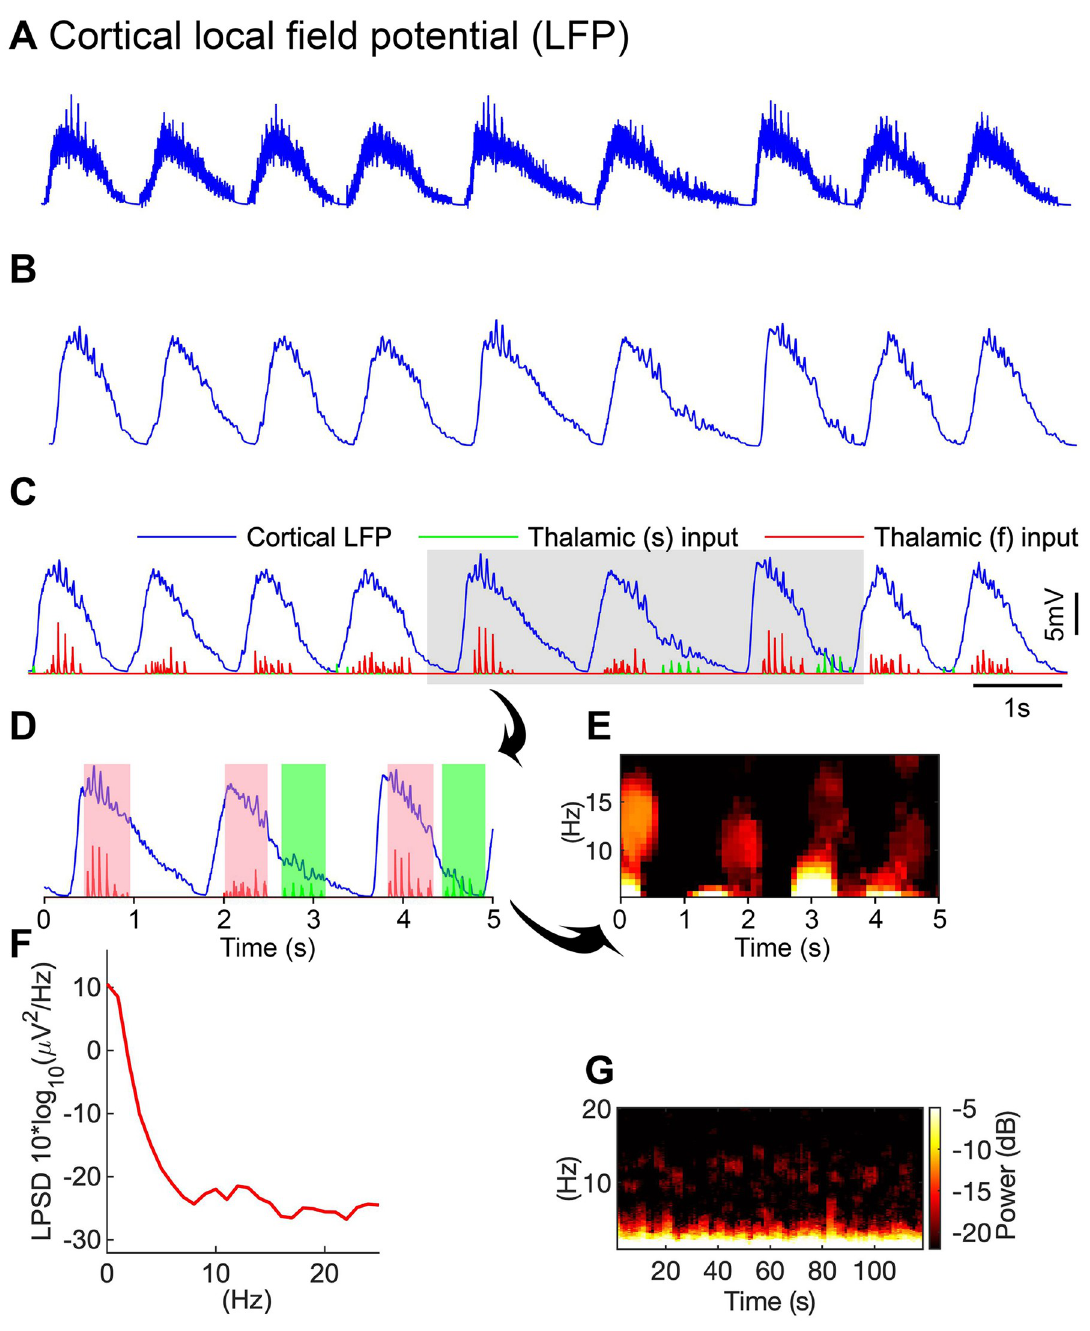
Fig 3. Resultant cortical local field potential (LFP). A , Cortical LFP calculated as the sum of presynaptic currents (AMPARs, NMDARs, GABA A Rs) of PY cells. B , Smoothed LFP revealing up and down SO states more clearly. C , Spontaneously occurring Cortical LFP indicating times of both thalamic synaptic inputs. The occurrence of slow and fast spindles varies during long time simulations. The ‘fast thalamic’ input (red) responsible for fast spindle generation occurs at the SO down-to-up state transition SO. The slow thalamic input (green) is responsible for slow spindle generation and occurs at the SO up-to-down state transition. D , zoomed figure of C indicating fast thalamic spindle (red) input nested within the first SO-half (pink filled box, time period of ~500 ms). The green input and green filled box describe slow thalamic input and its time period. E , time-frequency spectrogram (calculated by short-time moving window Fourier transform) (range, 5–20 Hz) of LFP, for shaded area (panel E) indicates the bands of fast and slow spindles. F , Log power spectrum of the LFP across the time period of 120 s, exhibiting power in the SO (~1 Hz), slow spindle (8–12 Hz), and fast spindle (12–16 Hz) frequency bands. G , time-frequency spectrogram (range 0–25 Hz) of the LFP of 120 seconds duration indicates SO, fast and slow spindle